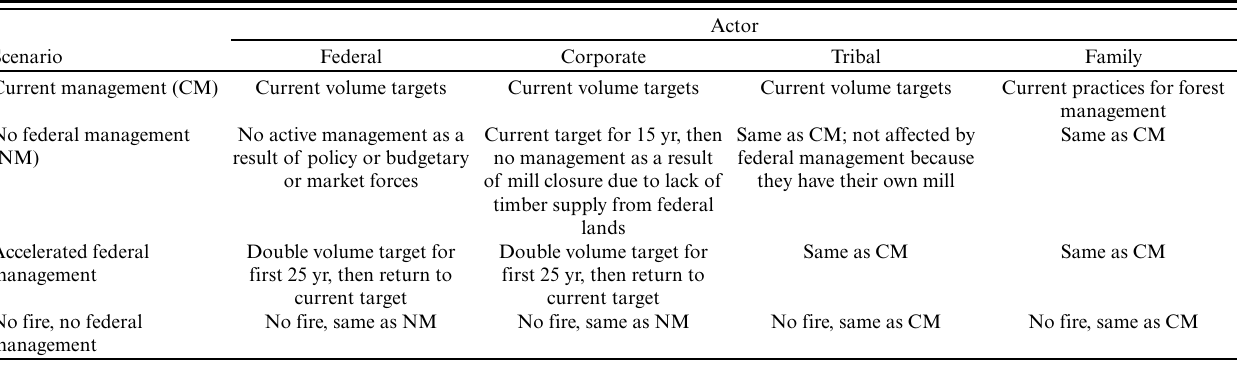
Table 3. Description of scenarios by actor category.